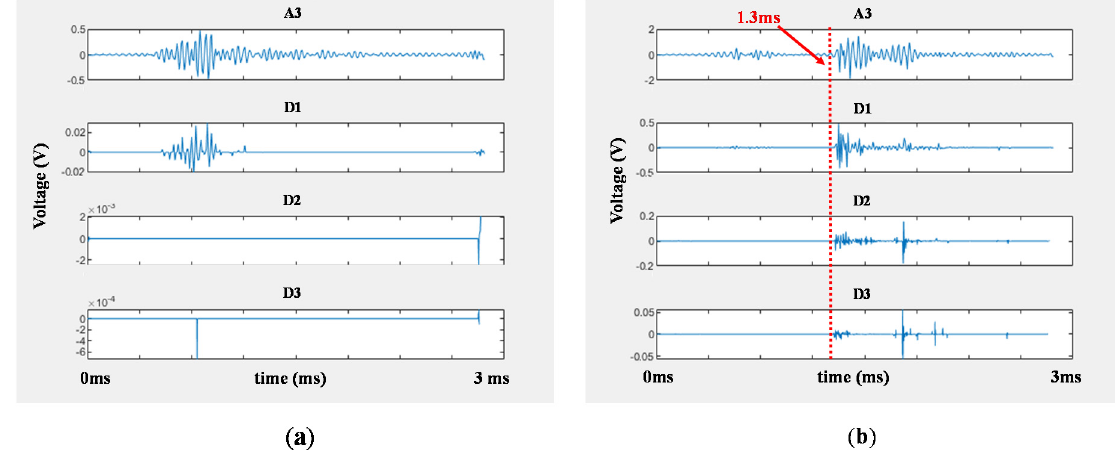
Figure 13. DWT coe ffi cients of PVDF sensor signal of di ff erent damage state: ( a ) impact energy 9 J Figure 13. DWT coefficients of PVDF sensor signal of different damage state: ( a ) impact energy 9 J (intact) ( b ) impact energy 12 J (intact) ( b ) impact energy 12 J (damaged).